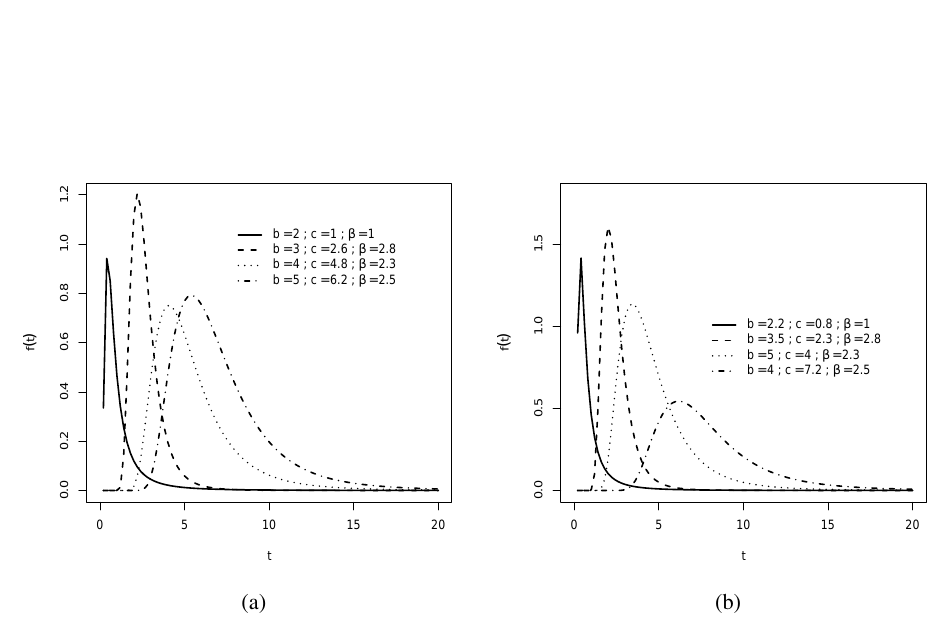
Fig. 1. Kumaraswamy inverse Weibull density functions.